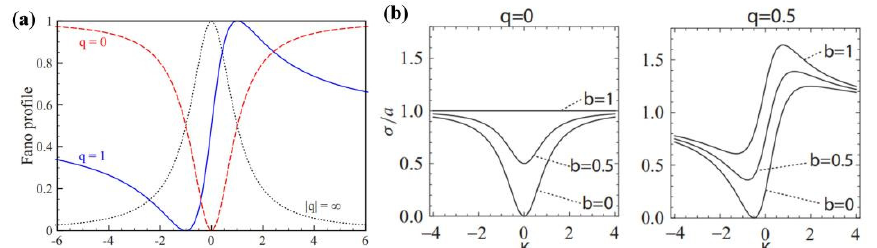
Figure 1. ( a ) Fano profile with different q values. Adapted with permission from Ref. [21]. Copyright (2010), American Physical Society. ( b ) The scattering cross–section of Fano with different b values. Adapted with permission from Ref. [54]. Copyright (2011), American Physical Society.